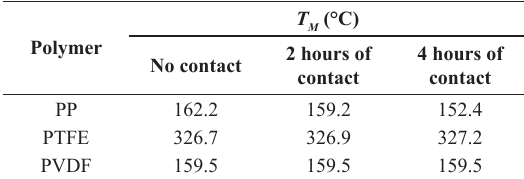
Table 2. Melting temperature of membrane samples before and after ozone